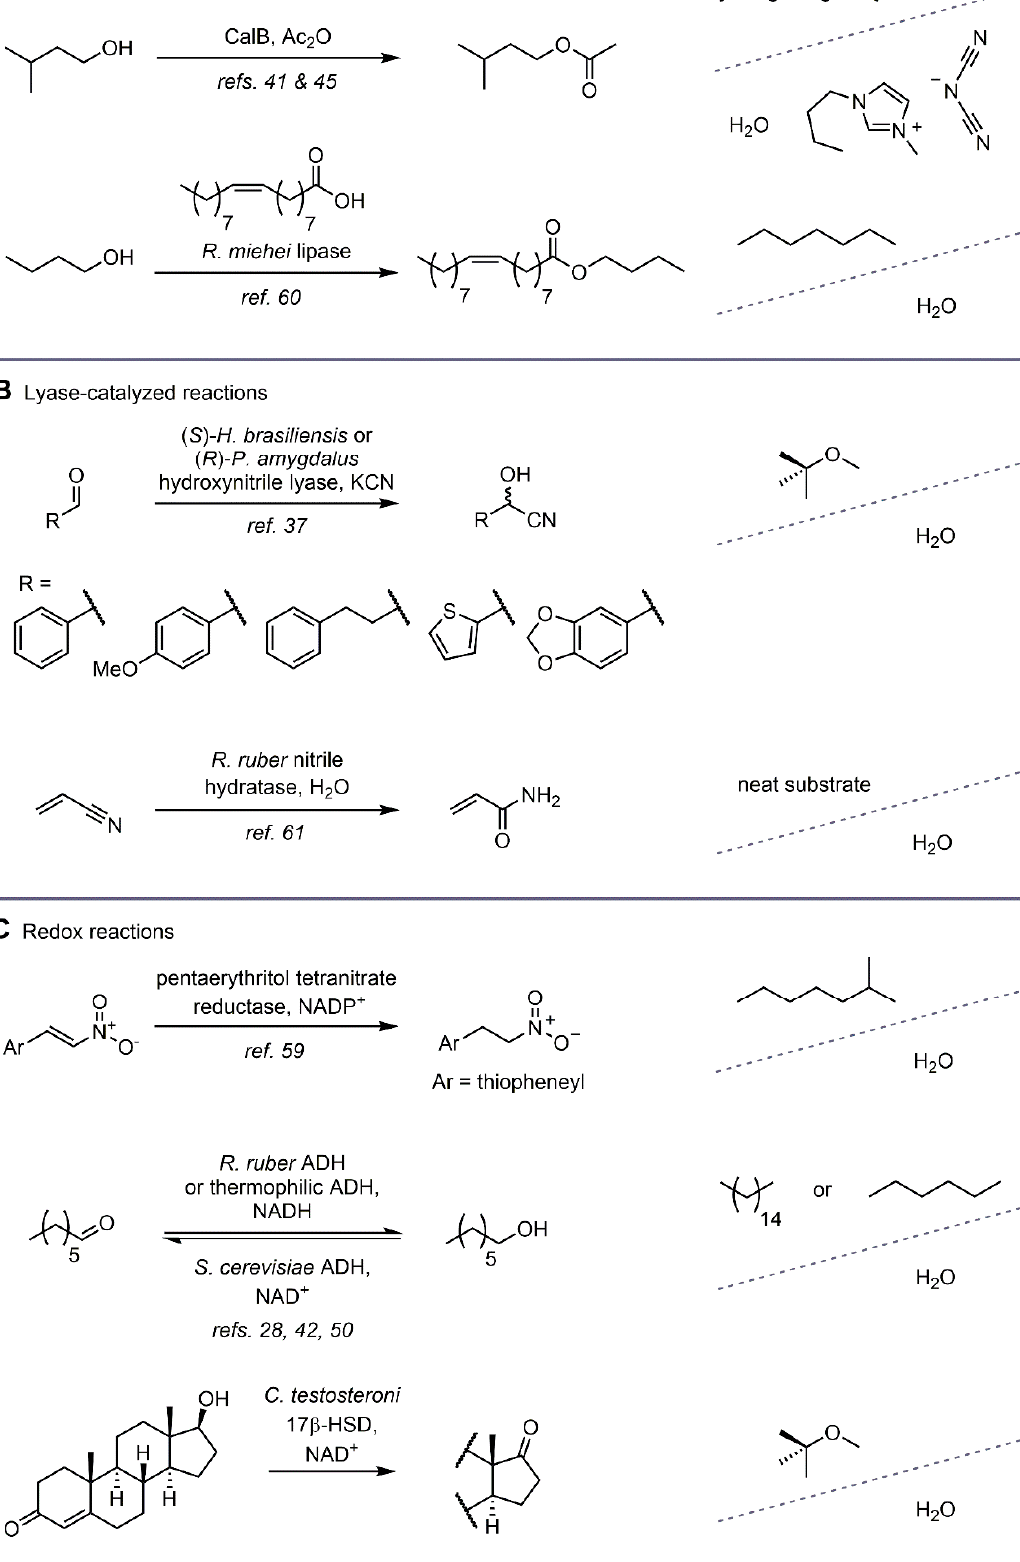
Figure 6. Biocatalytic two ‐ phase reaction examples performed in microfluidic droplets.